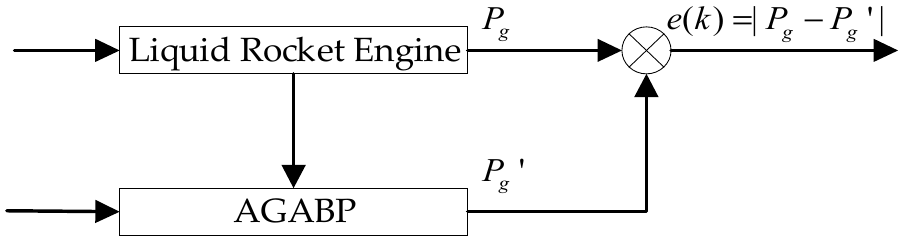
Figure 4. The algorithm diagnosis principle.